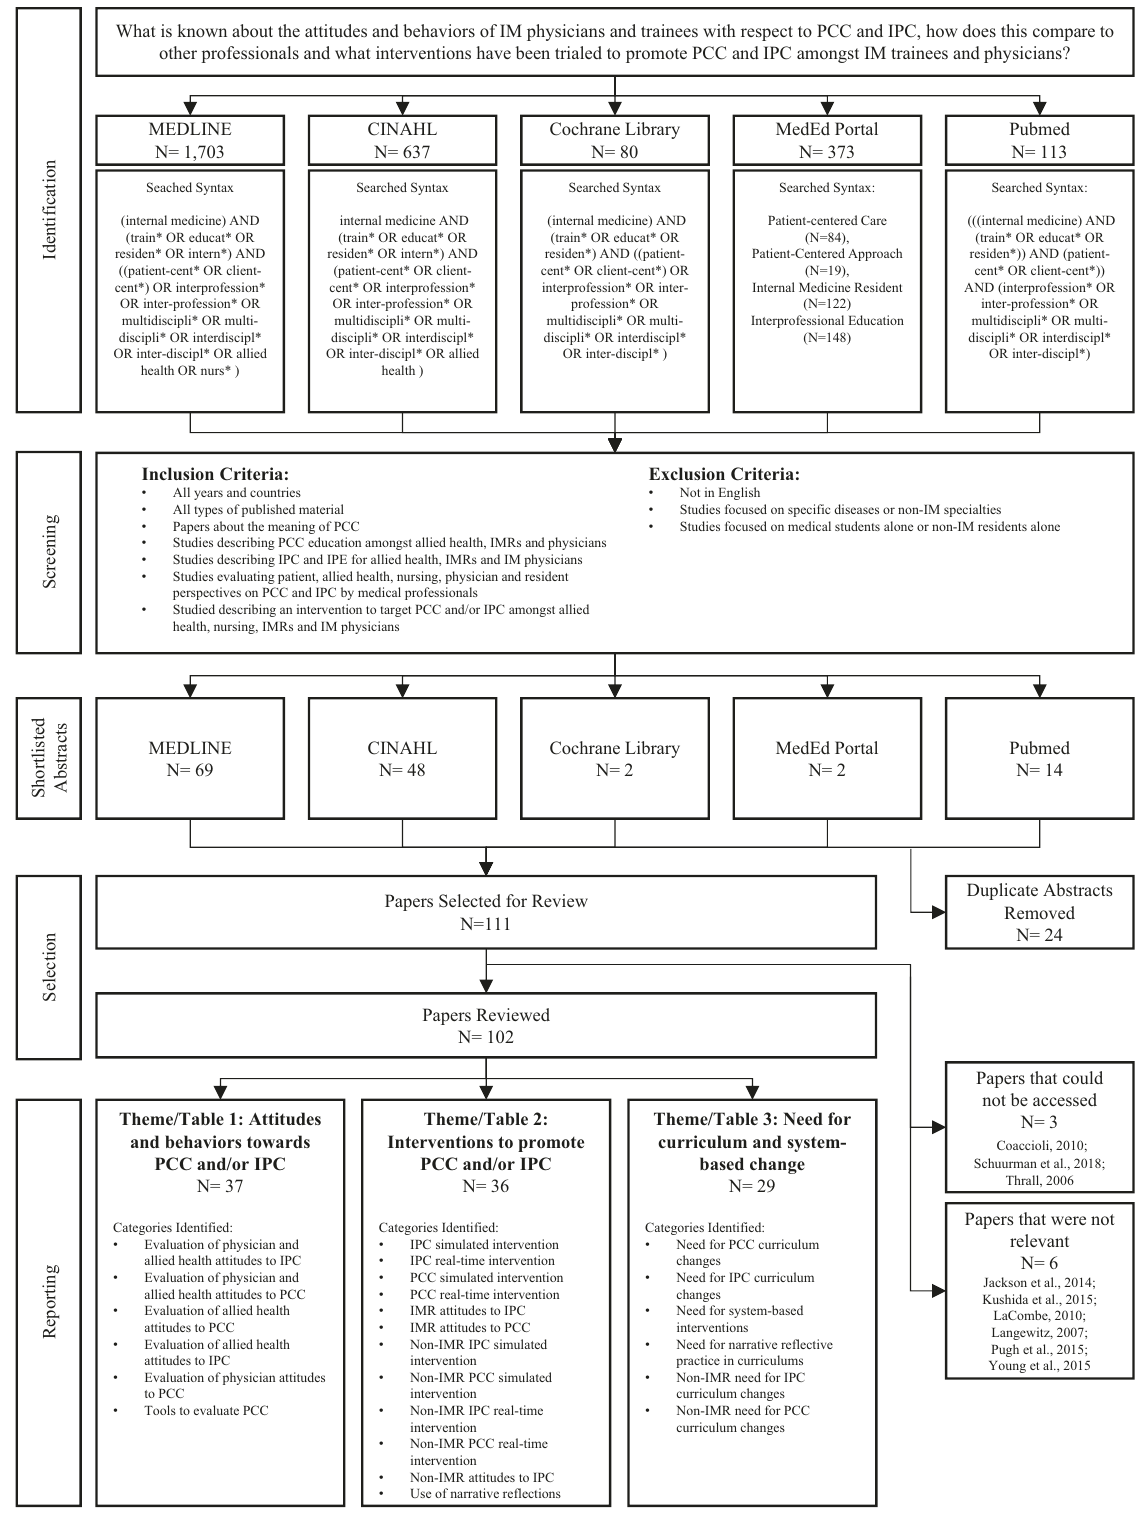
Fig. 1 Search strategy. PCC patient-centered care, IPC interprofessional collaboration, IM internal medicine, IPE interprofessional education, IMR internal medicine